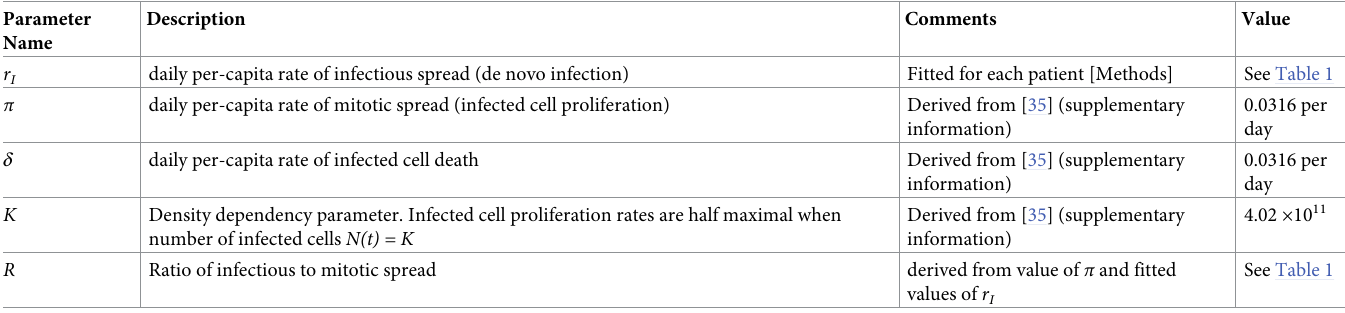
Table 2. Parameter names and